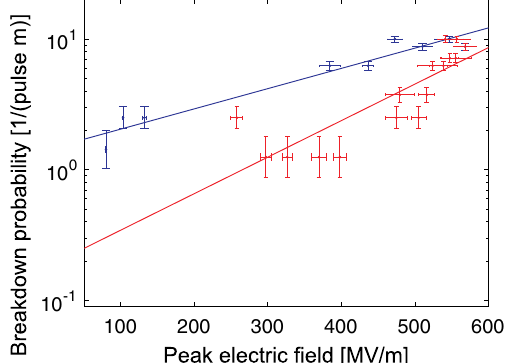
FIG. 8. Horizontal breakdown probability versus peak surface electric field obtained in a horizontal scan, 0.9 mm gap. The blue line is for increasing gradient and the red is for decreasing gradient. The electric peak field is calculated considering all